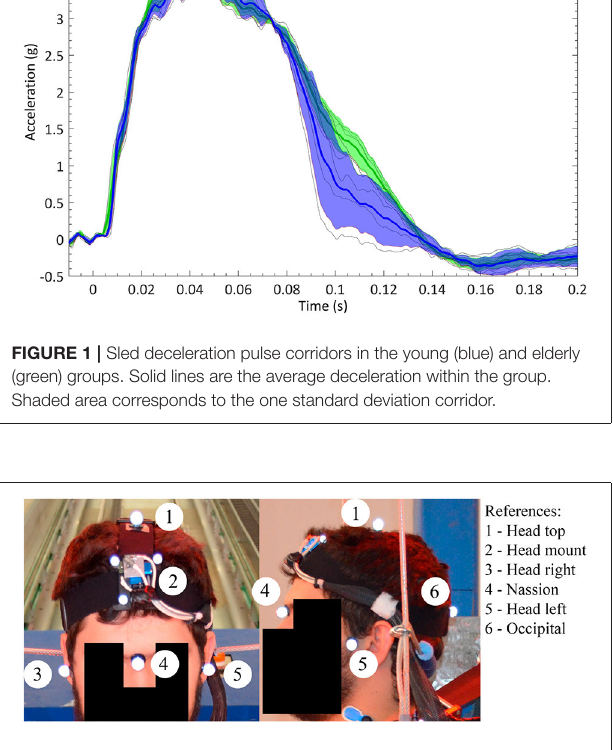
FIGURE 2 | Detail of the 6 degree-of-freedom head cube and of the position of the sensors on the head of one of the volunteers.